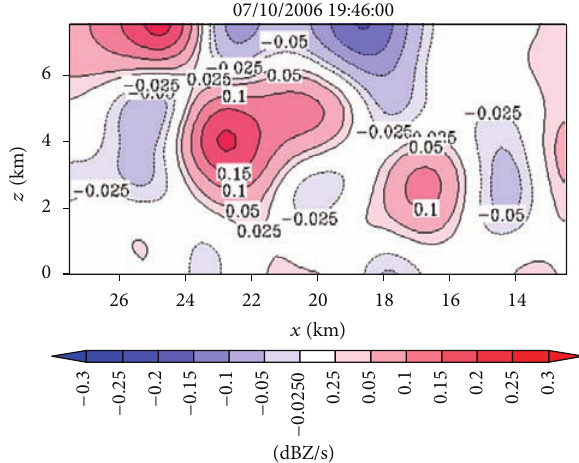
Figure 7: Reflectivity source field (for the 𝑆 𝑚2 term on the right- hand side of (13a)) produced in the vertical cross-section as a by- product of the retrieval in Figure 6(c). The color scale is shown on the bottom, and the unit is dBZs −1 for the labeled contour